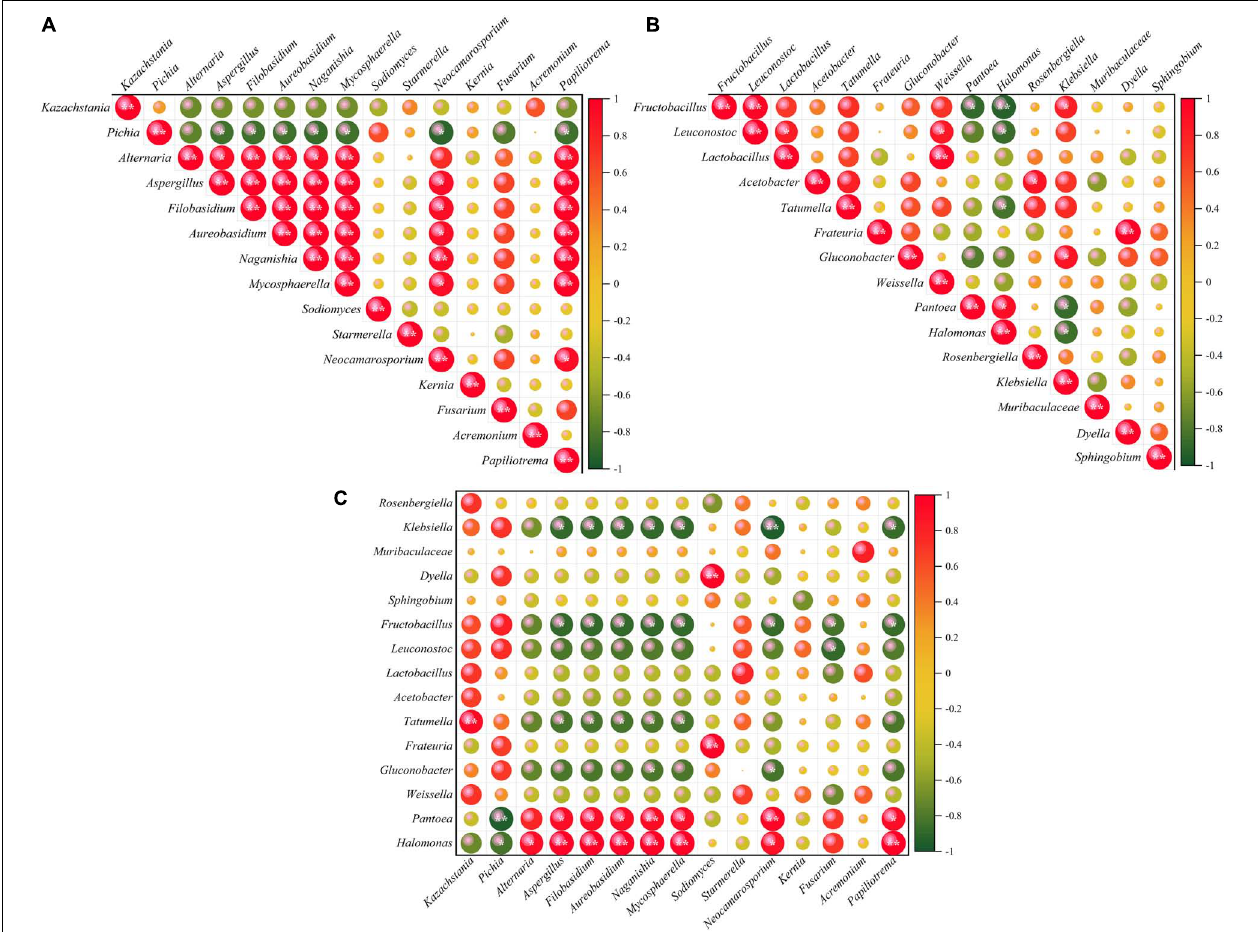
FIGURE 4 | Co-occurrence and co-exclusion relationships between different bacteria (A) and fungi (B) and between bacteria and fungi (C) . The Pearson rank correlation matrix showing the abundance of the top 30 fungi and bacterial genera is depicted. Strong correlations are indicated by large circles, whereas weak correlations are indicated by small circles. The color of the scale bar denotes the nature of the correlation, with 1 indicating a perfect positive correlation (red) and -1 indicating a perfect negative correlation (green). Significant correlations (| r | > 0.7, P < 0.01) and (| r | > 0.9, P < 0.01) are indicated by * and **,